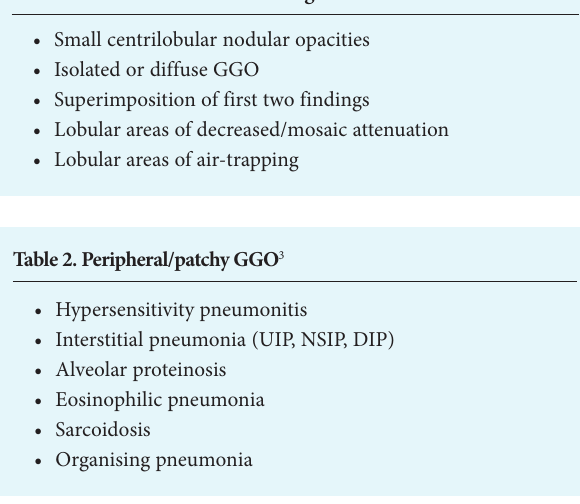
Table 1. Subacute HP HRCT findings 1,3